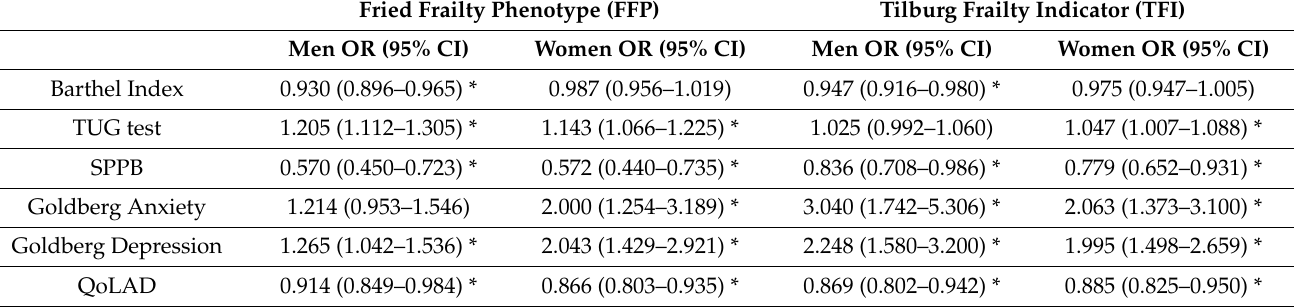
Table 2. Simple logistic regression for frailty measures, including parameters analyzed as independent variables stratified by